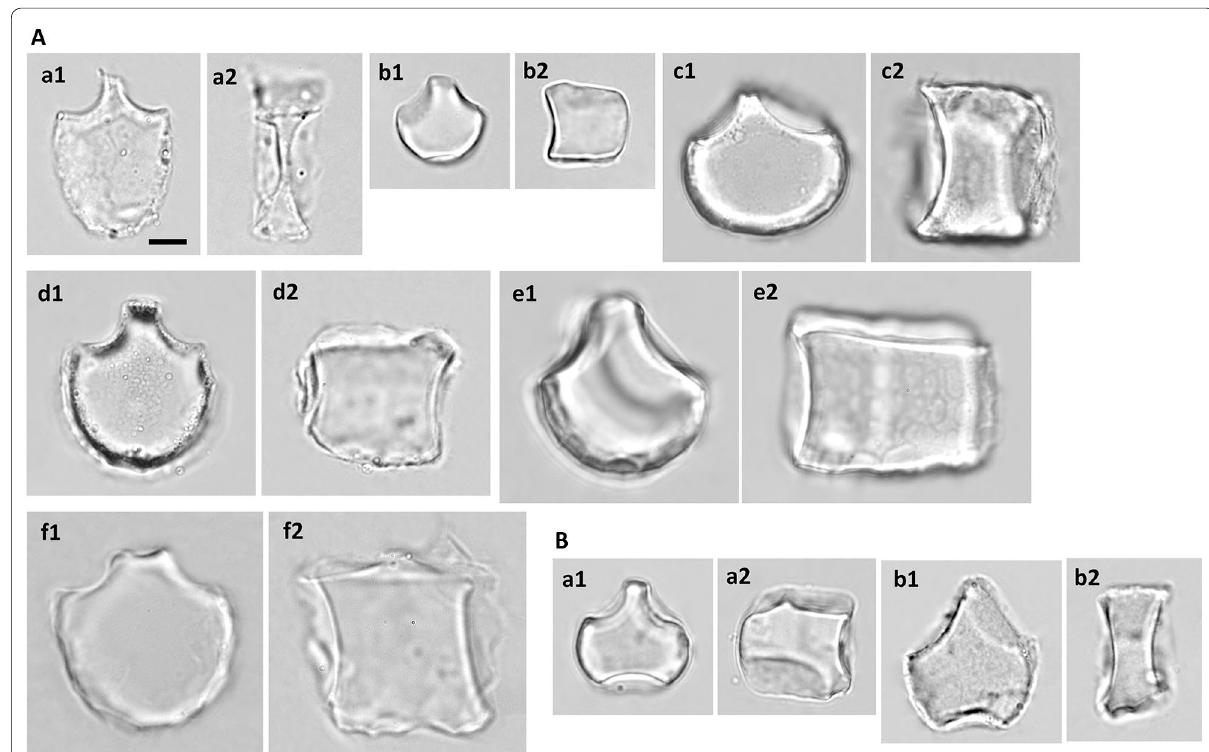
Fig. 13 Bulliform phytoliths of subfamily Chloridoideae. A, morphotype Chl_I; B, morphotype Chl_II. A a E. amabilis ; b Eragrsotis sp.; c S. indicus ; d C. barbata ; e D. aegyptium ; f E. indica . B a Z. matrella ; b C. dactylon . 1 , end view; 2 , lateral view. Bar 10 μm, all pictures are in the same